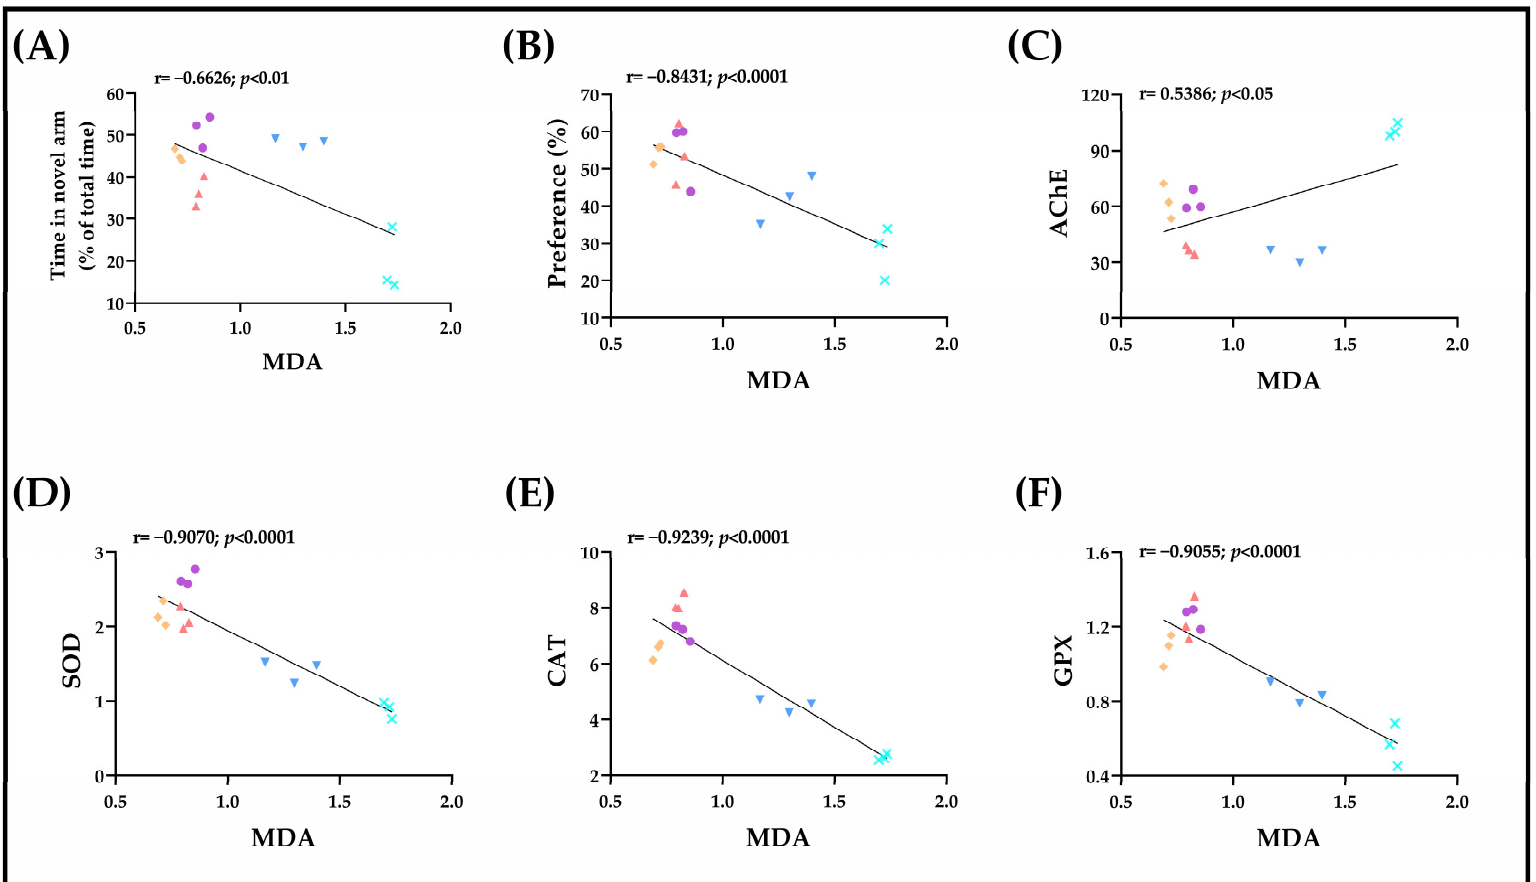
Figure 6. Pearson correlations between the behavioral and biochemical results. Data are expressed as time in novel arm (% of total time), preference (%), MDA (nmoles MDA/mg protein), AChE (nmoles acetylthiocholine (ACTh)/min/mg protein), SOD (U SOD/mg protein), CAT (U CAT/mg protein) and GPX (U GPX/mg protein). ( A ) Time in novel arm vs. MDA ( n = 3, r = −0.662, p < 0.01), ( B ) preference vs. MDA ( n = 3, r = −0.843, p < 0.0001), ( C ) AChE vs. MDA ( n = 3, r = 0.538, p < 0.05), ( D ) SOD vs. MDA ( n = 3, r = −0.907, p < 0.0001), ( E ) CAT vs. MDA ( n = 3, r = −0.923, p < 0.0001) and ( F ) GPX vs. MDA ( n = 3, r = −0.905, p < 0.0001) in control (●), scopolamine (SCOP, Χ), galantamine (GAL, ♦ ), Glaucosciadium cordifolium essential oil (GCEO) 25 µL/L ( ▼ ) and 150 µL/L ( ▲ ) groups.